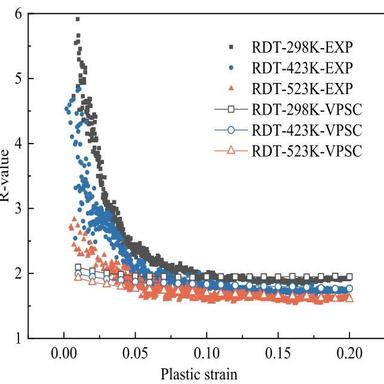
Comparison of the experimental and predicted R-values in RDT, indicating that the experimental R-values can be well reproduced at the higher levels of deformation by using the calibrated VPSC model.